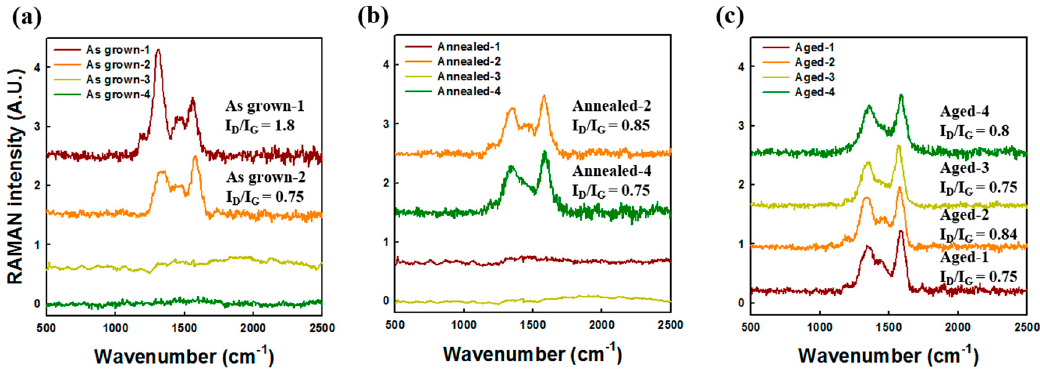
Figure 9. Normalized Raman spectra of patterned ( a ) as-grown, ( b ) annealed, ( c ) and electrically aged CNTs.